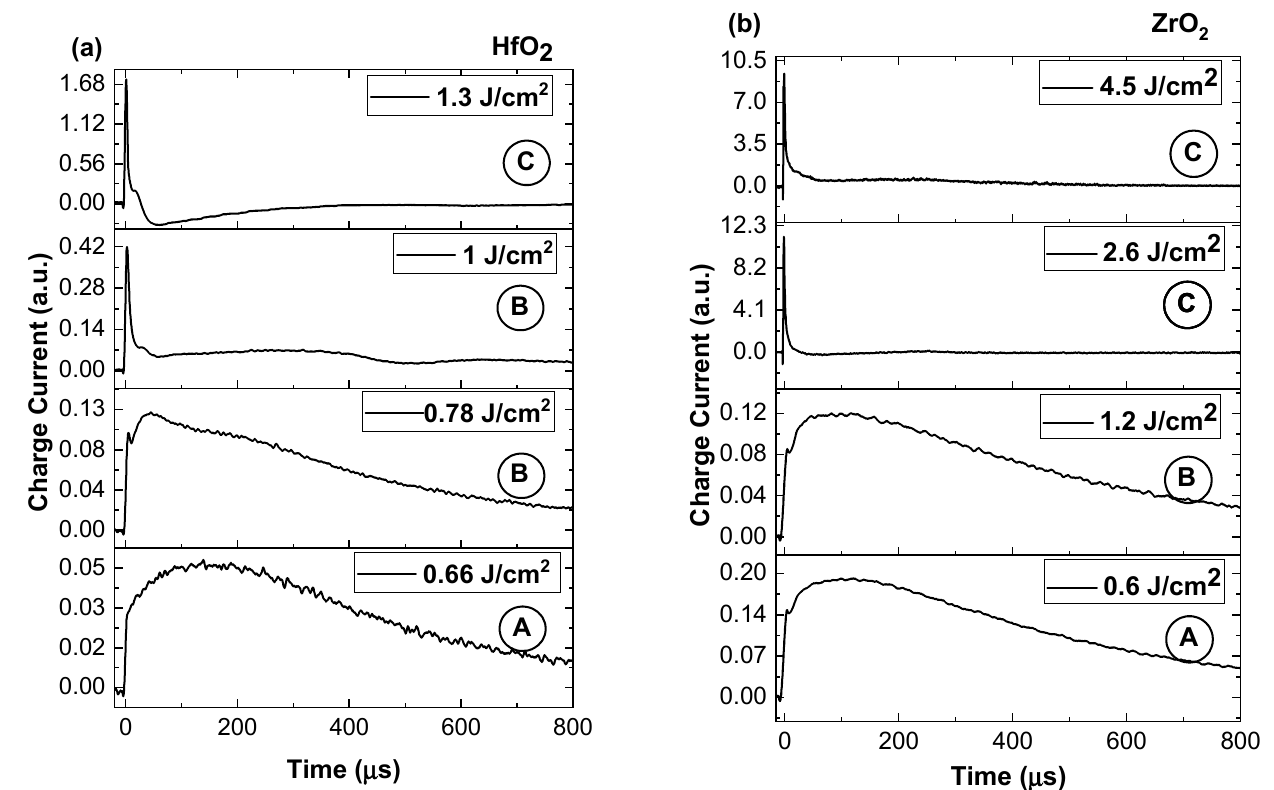
Figure 5. Time of arrival charge traces recorded for HfO 2 ( a ) and ZrO 2 ( b ) characterizing the three fluence regimes (the A, B, C, corresponds to the regimes identified in Figure 4). In order to explore the kinetic regimes of the plasmas generated in various irradiation regimes, the approach from [18] was implemented. The charge density distribution with the expansion velocity were derived and plotted in Figure 6. For the study performed on the HfO 2 sample, some strong changes can be seen for the two regimes. When the laser fluence is below the threshold value (Figure 6a), the velocity distribution extends up to 1.5 km/s, with the core of the plasma having 0–0.5 km/s, with the most probable kinetic energy of the ablated particle cloud being 2.6 × 10 − 2 eV. Indeed, the distribution is characteristic for the expansion of particles in a low kinetic regime. Above the ablation regime for fluence values relevant to the pulsed laser deposition conditions (Figure 6b), a splitting of the distribution into multiple peaks is observed. The slow peak into 1.3 × 10 − 2 eV and 3 × 10 − 2 eV with an additional 3.7 eV tail, while the presence of a new peak characterizing a high kinetic expansion regime with a most probable energy of 268 eV. A further increase in laser fluence lead to the further shift of the slow peak into a 0.2 eV group and an increase of 0.9 eV of the secondary peak energy. The high kinetic group of ions have their most probable kinetic energy shifted up to 584 eV with the tail reaching 2 keV. These values are highly relevant for both high-power laser facilities where the kinetic energy will define a traveling distance of the ablated debris [33] and for pulsed laser deposition where the kinetic of the particle in the plasma phase can induce different growth mechanisms, defects, or special morphological features [33]. For the ZrO 2 sample, the distribution followed a similar evolution, with overall higher values of the kinetic energy by a factor of